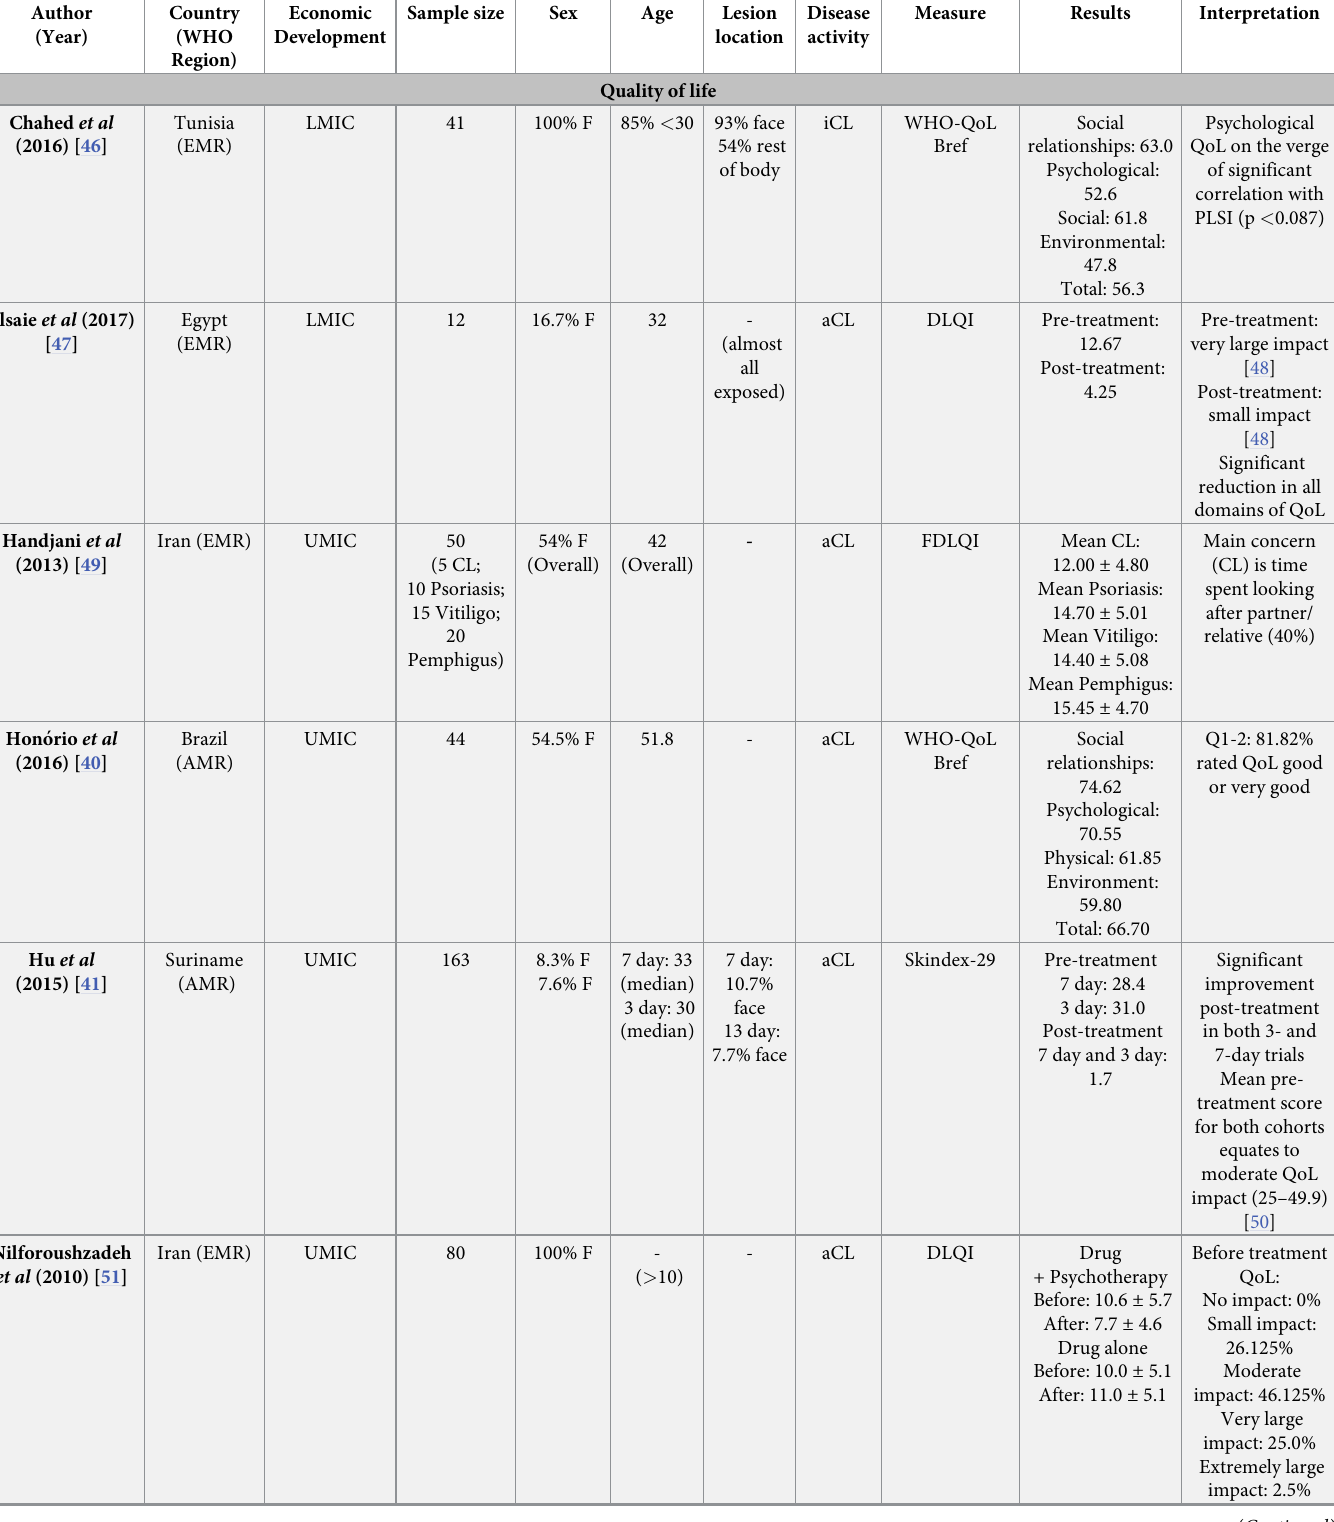
Table 2. Quantitative studies: Quality of life, psychological distress, stigma, socioeconomic impact